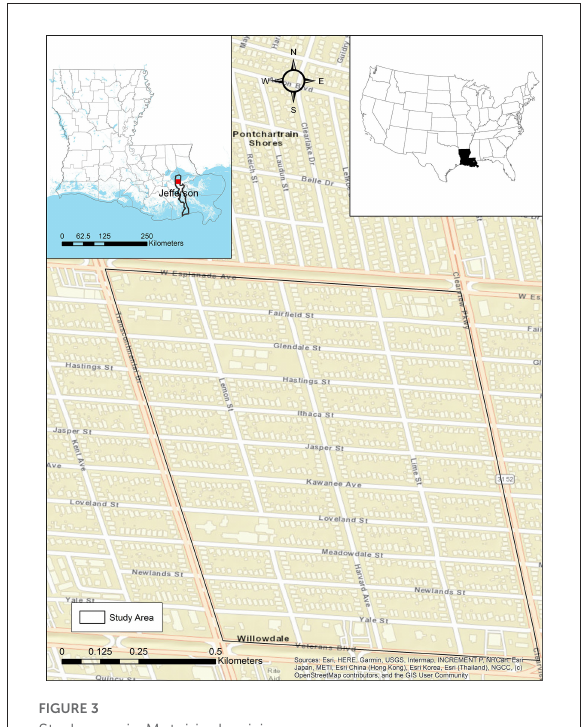
FIGURE3 Study area in Metairie,